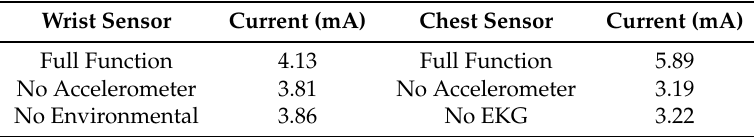
Table 2. HET average current